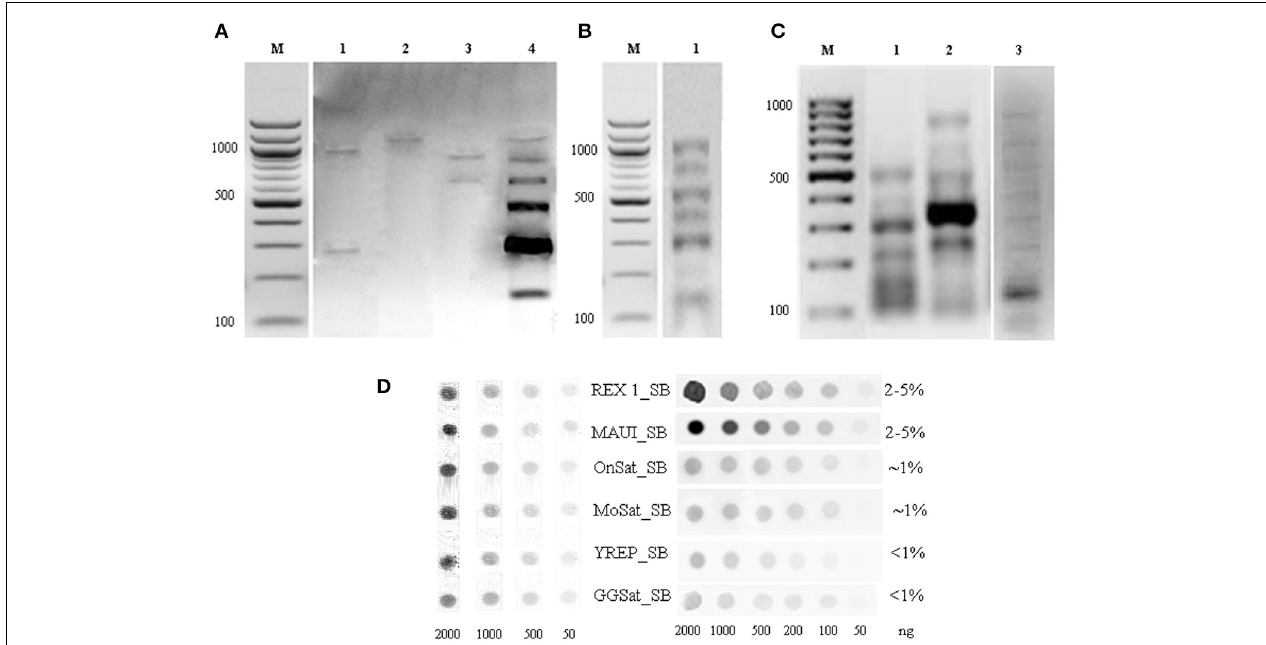
FIGURE 2 | Southern blot hybridization of Asian seabass genomic DNA (gDNA) digested by restriction endonucleases and hybridized with repeat-derived probes. (A) gDNA digested by EcoRI (1), HapI (2), BamHI (3), or RsaI (4) and hybridized with an OnSat_SB probe. (B) gDNA digested by HinfI and hybridized with a MoSat_SB (1) probe. (C) PCR fragment distribution of GGSat_SB (1), YRep_SB (2), and MoSat_SB (3) amplified with sequence-specific primers indicated in